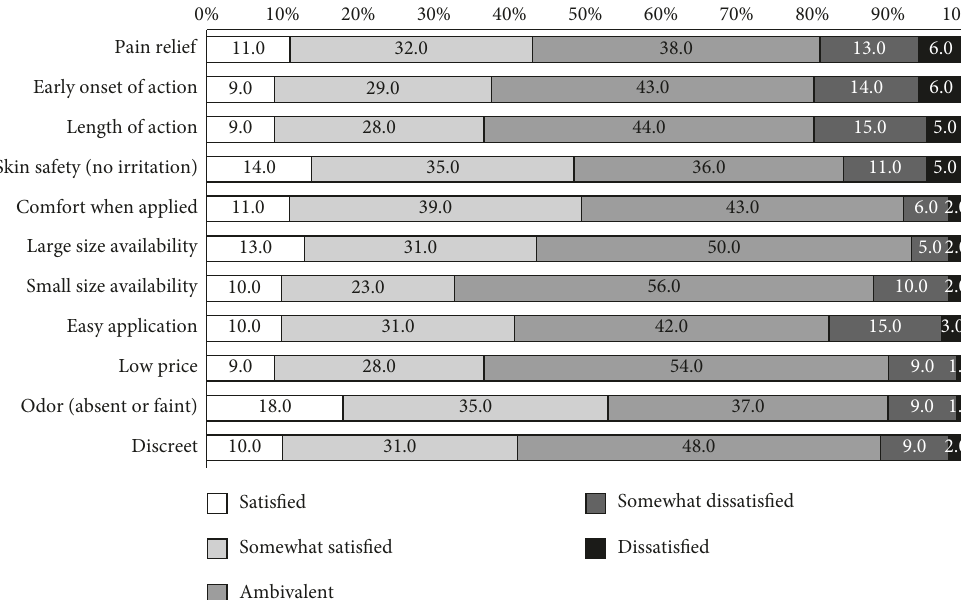
Figure 2: Patient survey: item-by-item satisfaction with NSAID plasters. Low satisfaction was reported in factors related to efficacy, cost, and availability of small size. High satisfaction was reported with skin safety, comfort when applied, and odor.